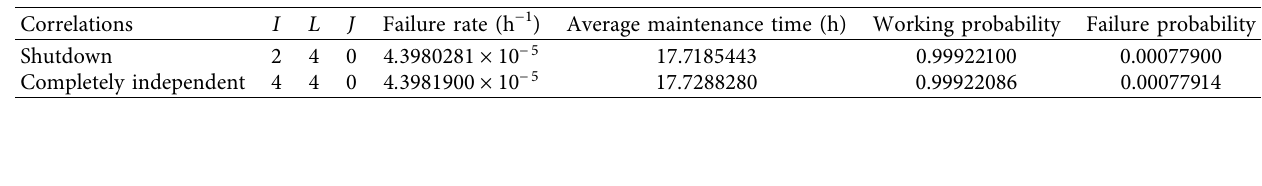
Table 12: Reliability analysis results of the MTS when considering different correlations.